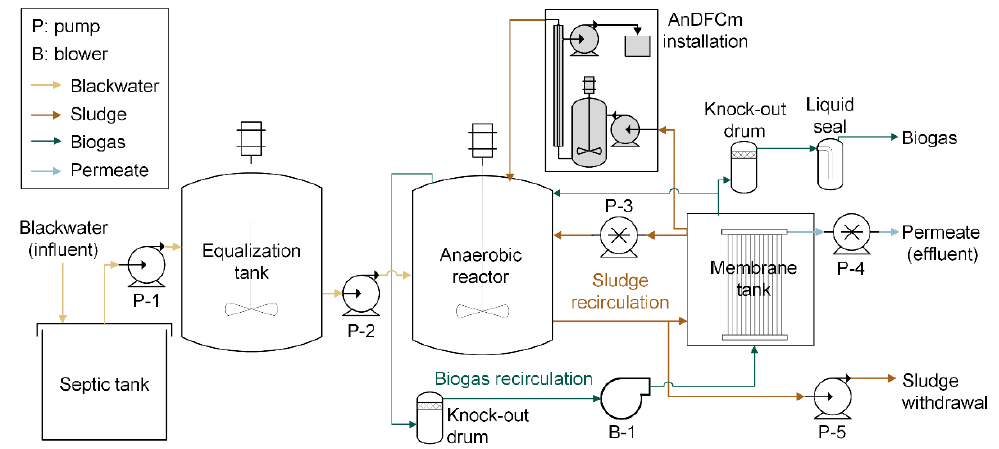
Figure 1. Scheme of the pilot AnMBR plant including the AnDFCm installation connected in bypass for in-situ sludge filterability measurements.